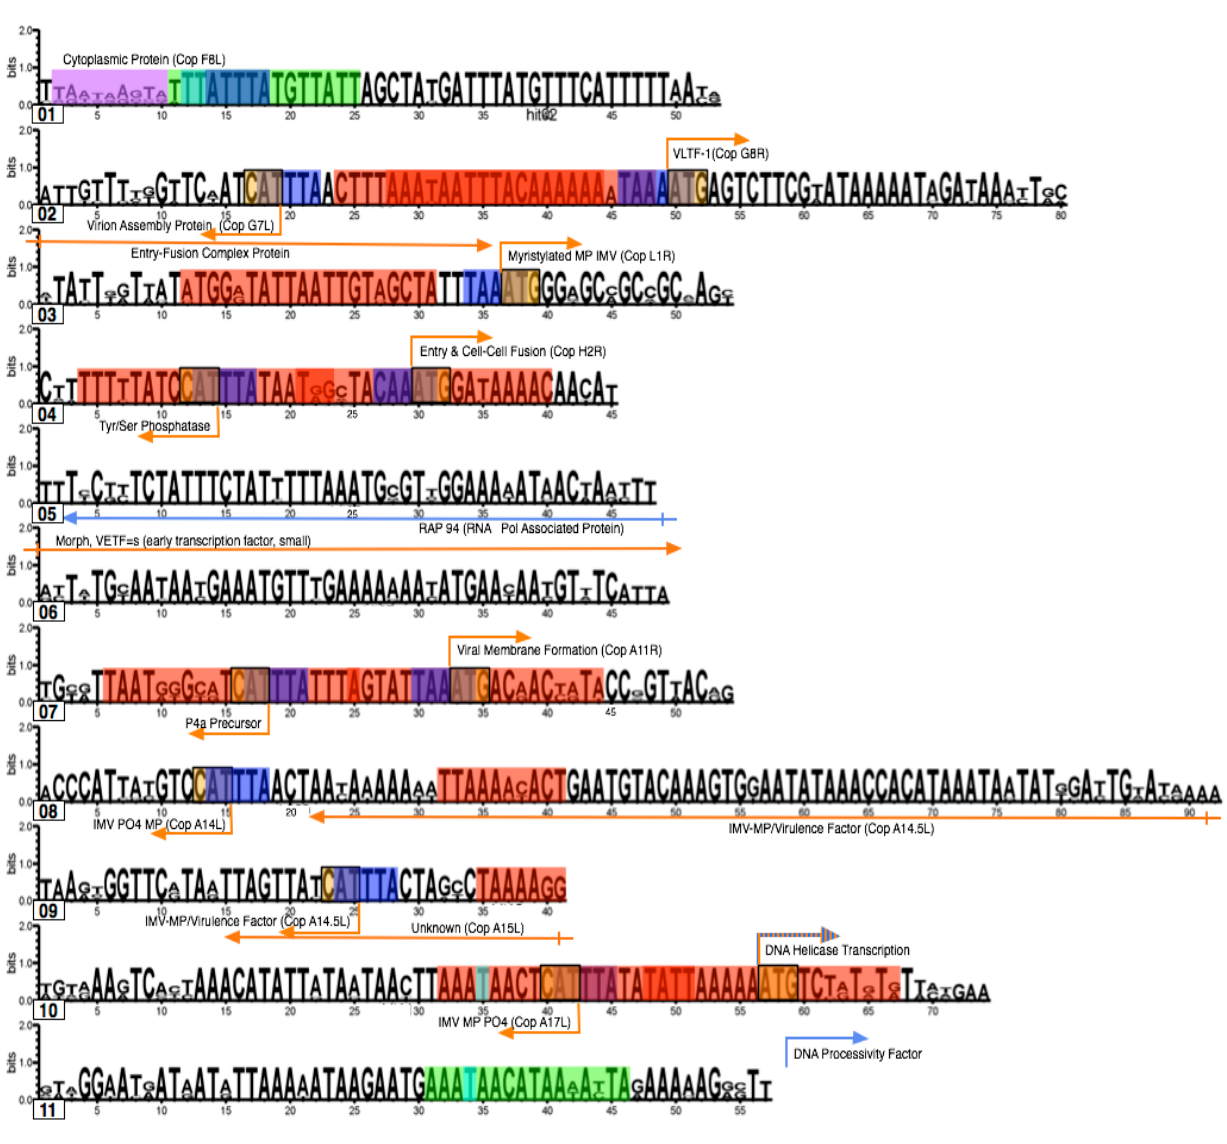
Figure 5. Annotated hit logos showing promoter elements; the hit number is indicated underneath (left) each logo. Blue arrows represent early genes, orange arrows represent late genes, and blue-and-orange striped arrows represent genes that are transcribed both early and late in the poxvirus life cycle. Highlighted promoter elements follow the color key shown in the diagram of the known consensuses of promoters (Figure